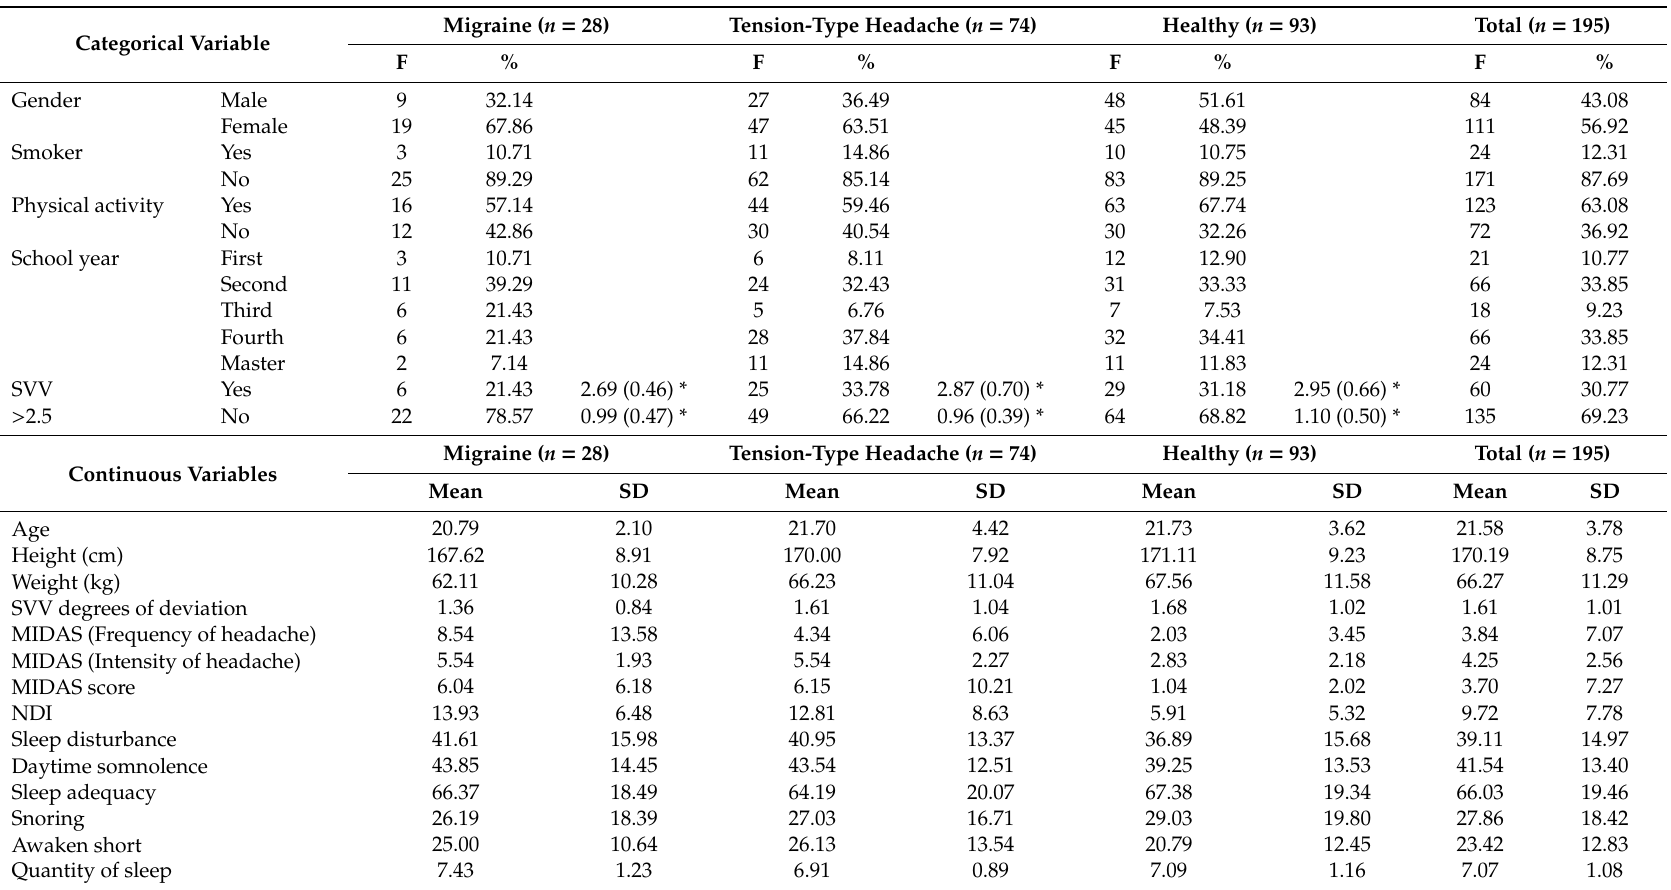
Table 1. Description of the samples and